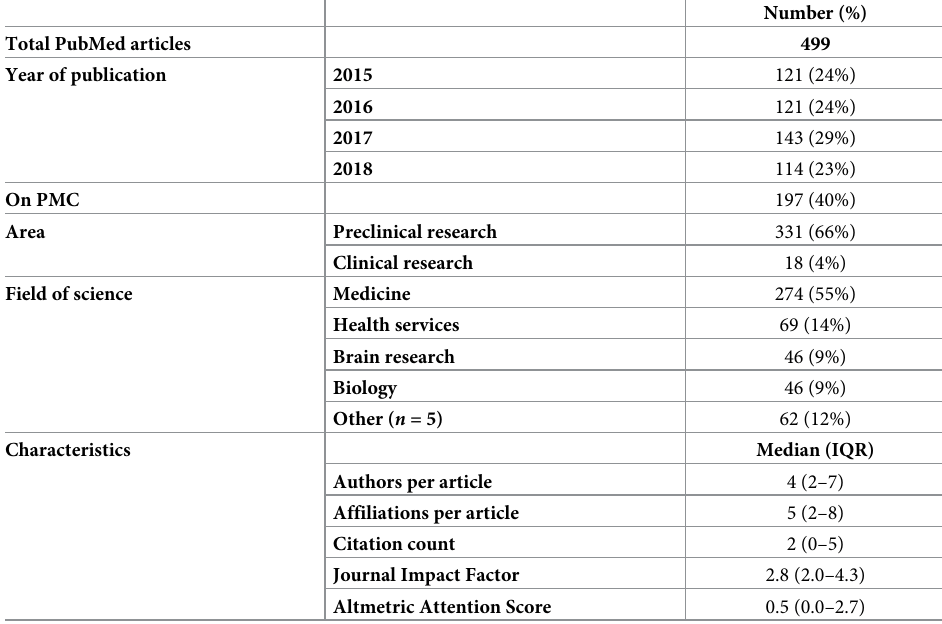
Table 1. Characteristics of 499 randomly selected English language articles from PubMed between 2015 and